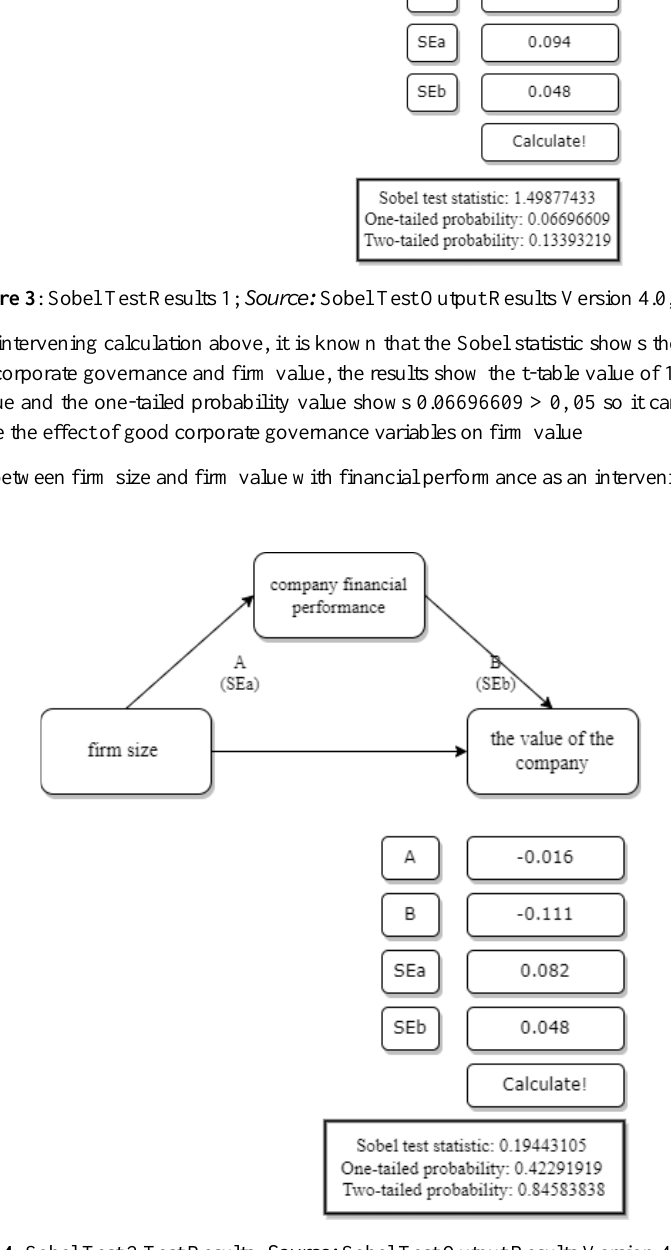
Figure 4 : Sobel Test 2 Test Results; Source: Sobel Test Output Results Version 4.0,